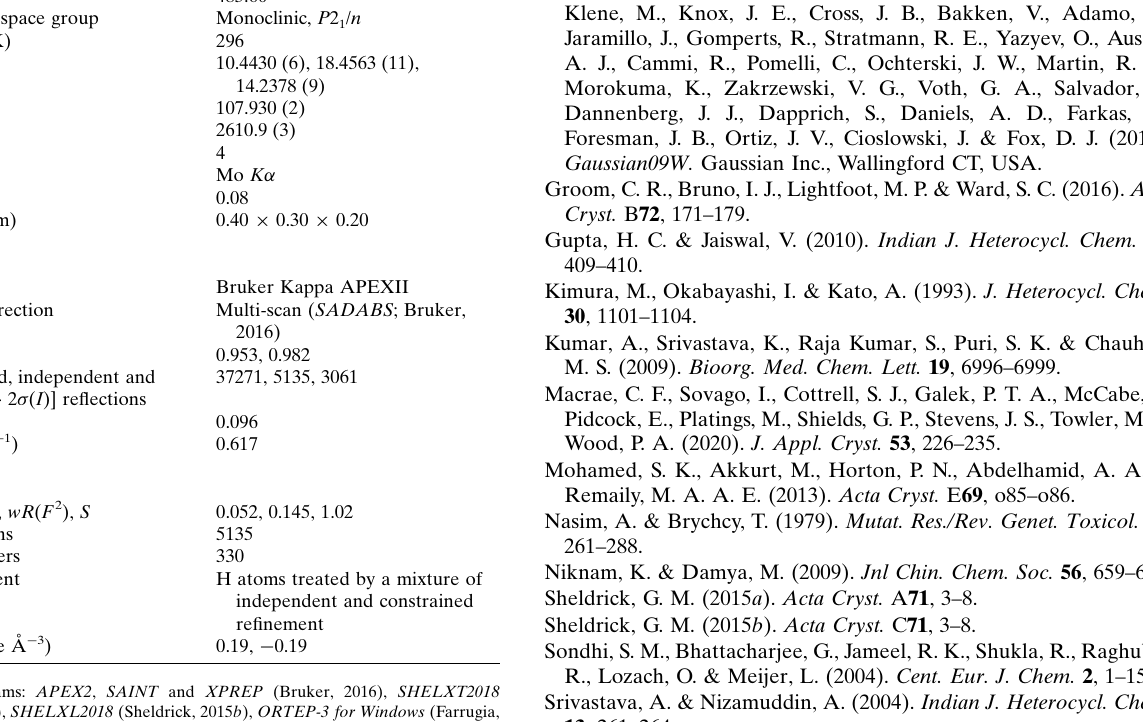
Table 5 Experimental details. Crystal data Chemical